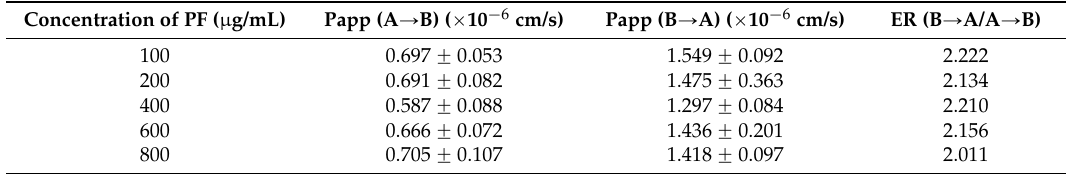
Table 1. Increasing concentration of PF transport across MDCK-MDR1 cell monolayers.